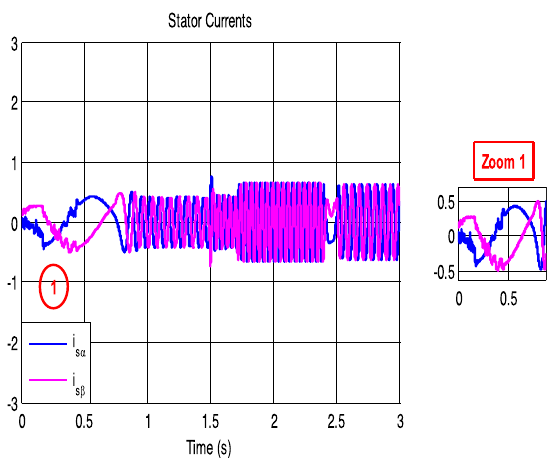
Fig. 27 PI-DTC-SPWM with five-level inverter stator current